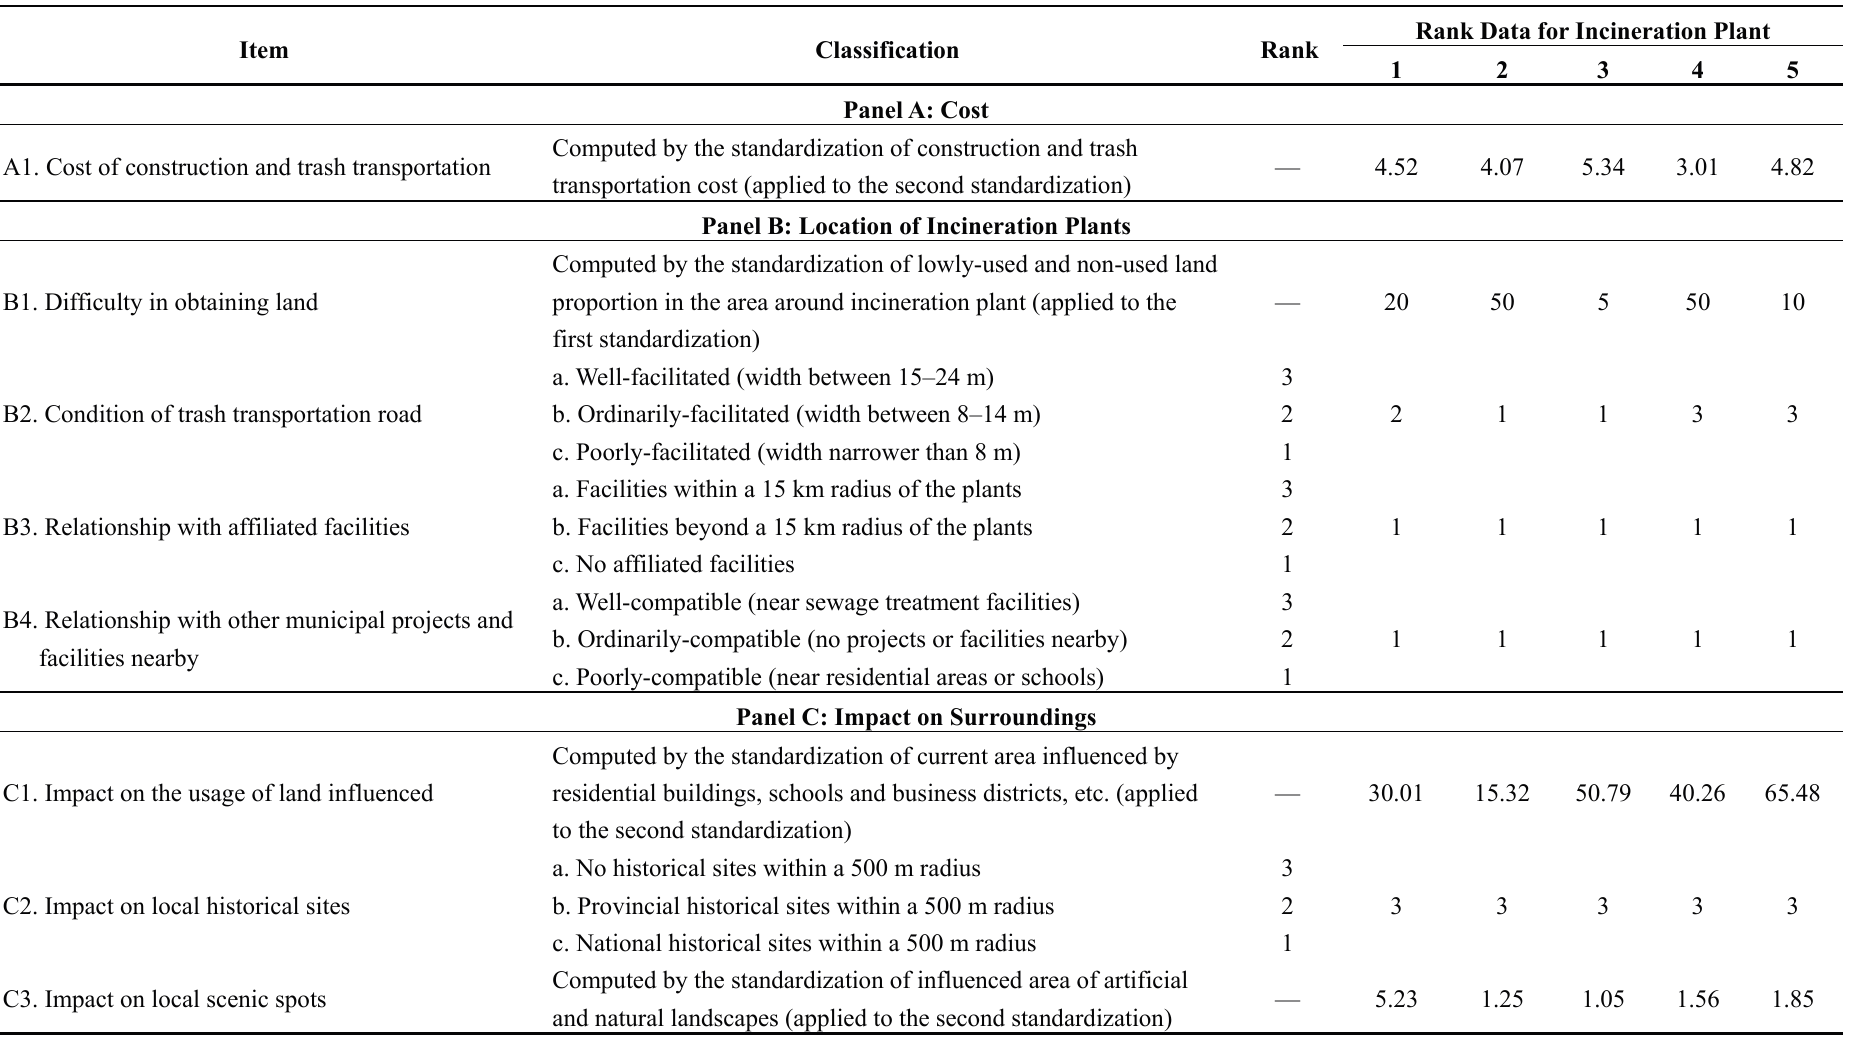
Table 4. The multi-criterion